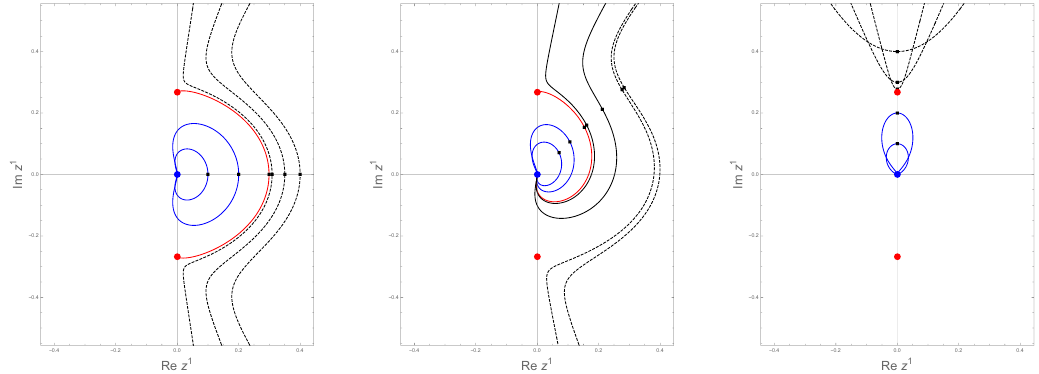
Figure 2. The family of BPS solutions for the N = 1 ∗ one mass model is summarised by paramet- rically plotting the real and imaginary parts of the scalar field z 1 . The black squares correspond to turning points of the function A J ( r ) and the three plots, from left to right, correspond to solutions where the phase of the complex scalar field at the turning point is 0 , π/ 4 and π/ 2 , respectively. The blue dot at the origin is the N = 4 SYM AdS 5 vacuum and the blue lines are Janus solutions. The two red dots are the two LS ± AdS 5 solutions, each dual to the Leigh-Strassler SCFT. In the middle plot the red curve is a conformal RG interface with N = 4 SYM on one side of the interface and the LS SCFT on the other. In the left plot the red curve is a conformal interface with LS on either side of the interface. The boundary of field space is | z 1 | = 1 and the black curves are singular on one or both ends. As one moves from r = −∞ to r = + ∞ one moves clockwise on the